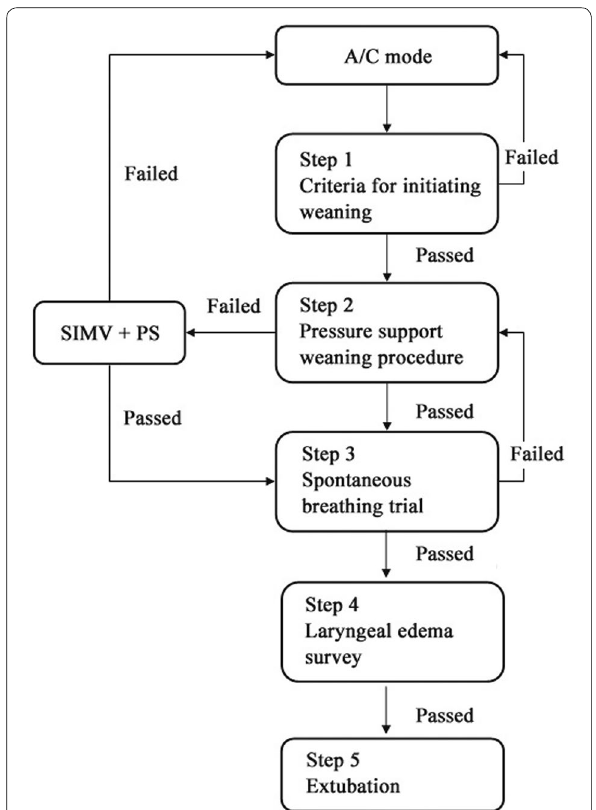
Fig. 1 Workflow of internal weaning protocol applied in patients from both EIT and control groups. A/C mode assist‑control mode. SIMV synchronized intermittent mandatory ventilation mode. PS pressure support